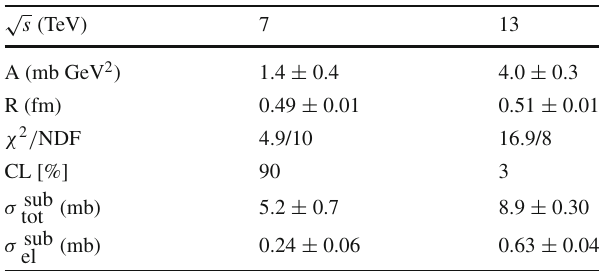
Table 2 The same as in Table 1 but at LHC energies √